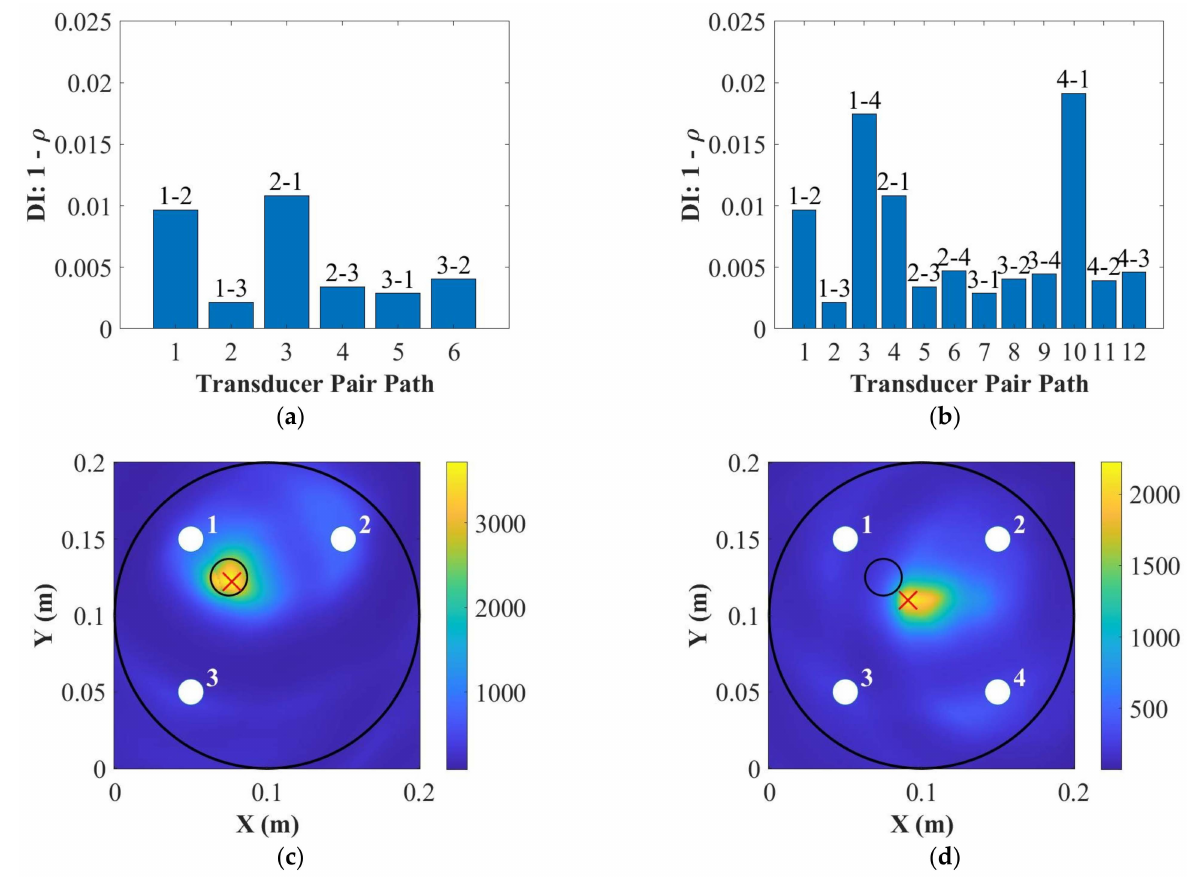
Figure 5. Delamination detection using ( a ) three PZT transducers and ( b ) four PZT transducers, and localization using ( c ) three PZT transducers and ( d ) four PZT transducers at 250 kHz for the position 1 (where the “ ” is the position for real damage and the “ × ” is the position for predicted damage). (cid:35)